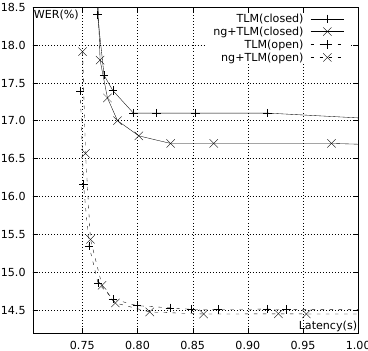
Figure 3. WER as a function of system latency (in seconds) for the closed-condition systems (solid line), computed over the dev1-dev set by trying different values for the search (pruning) parameters. An acoustic window size of 0.6s was used in all cases (plotted points). For comparison, relevant results for the open-condition systems are also shown (dashed line).